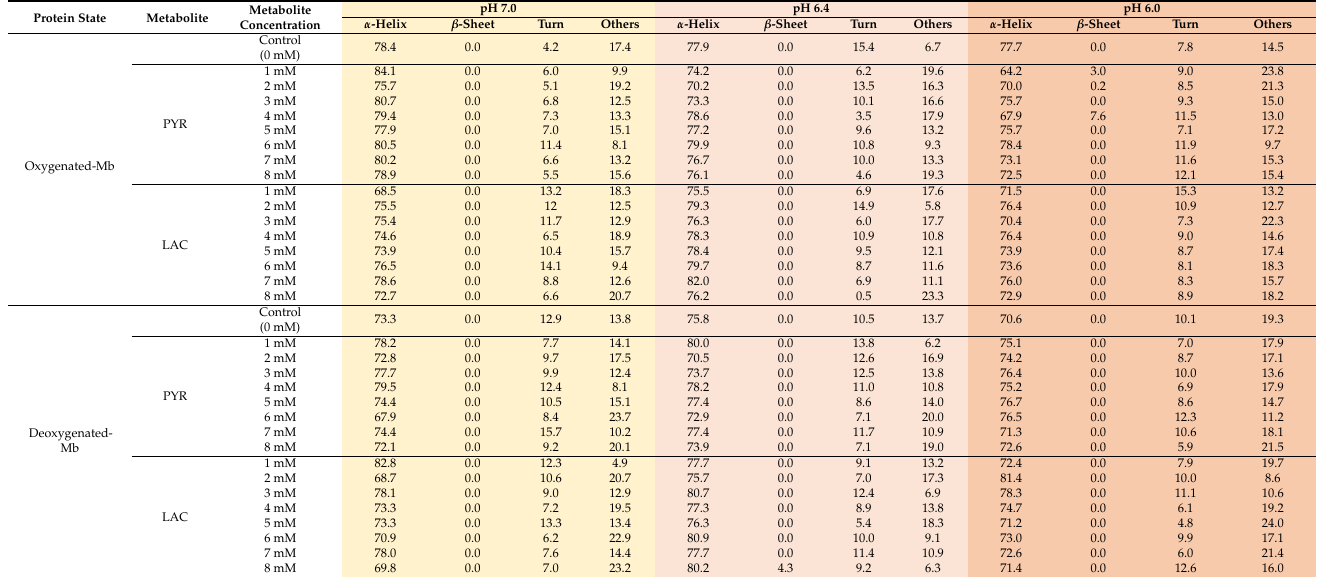
Table 2. Changes in secondary structure conformations (%) of Mb with varying concentrations of metabolite, PYR, and